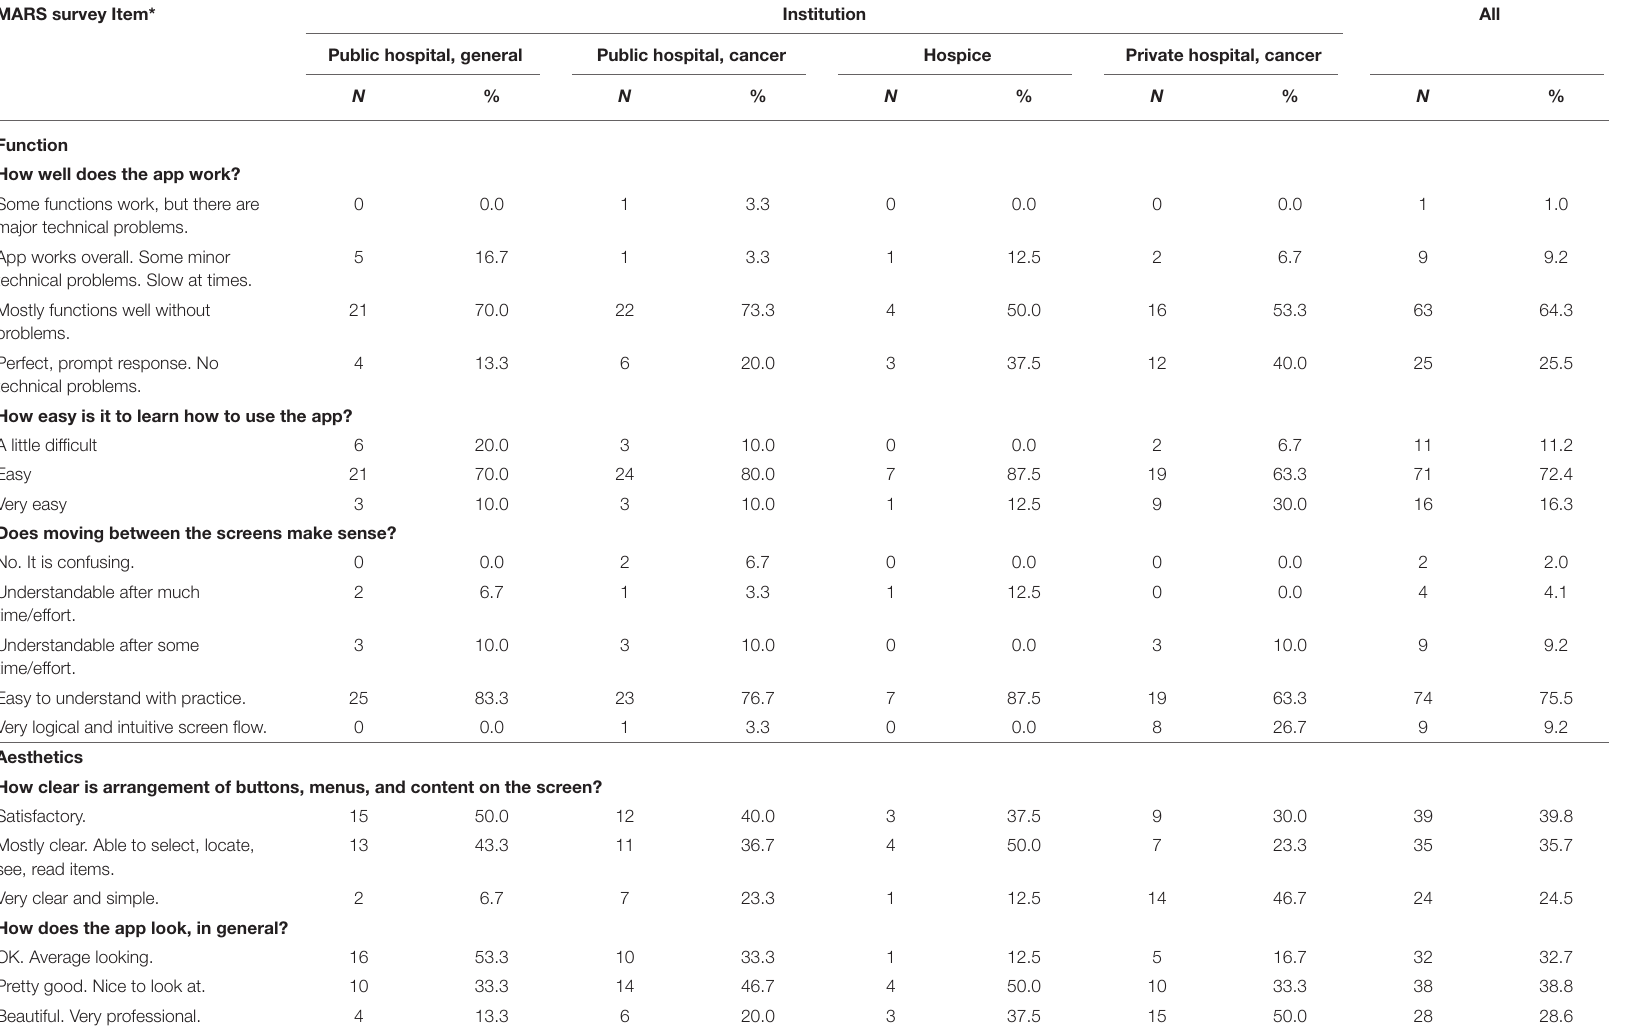
TABLE 6 | MARS survey responses, by institution. MARS survey Item* Institution